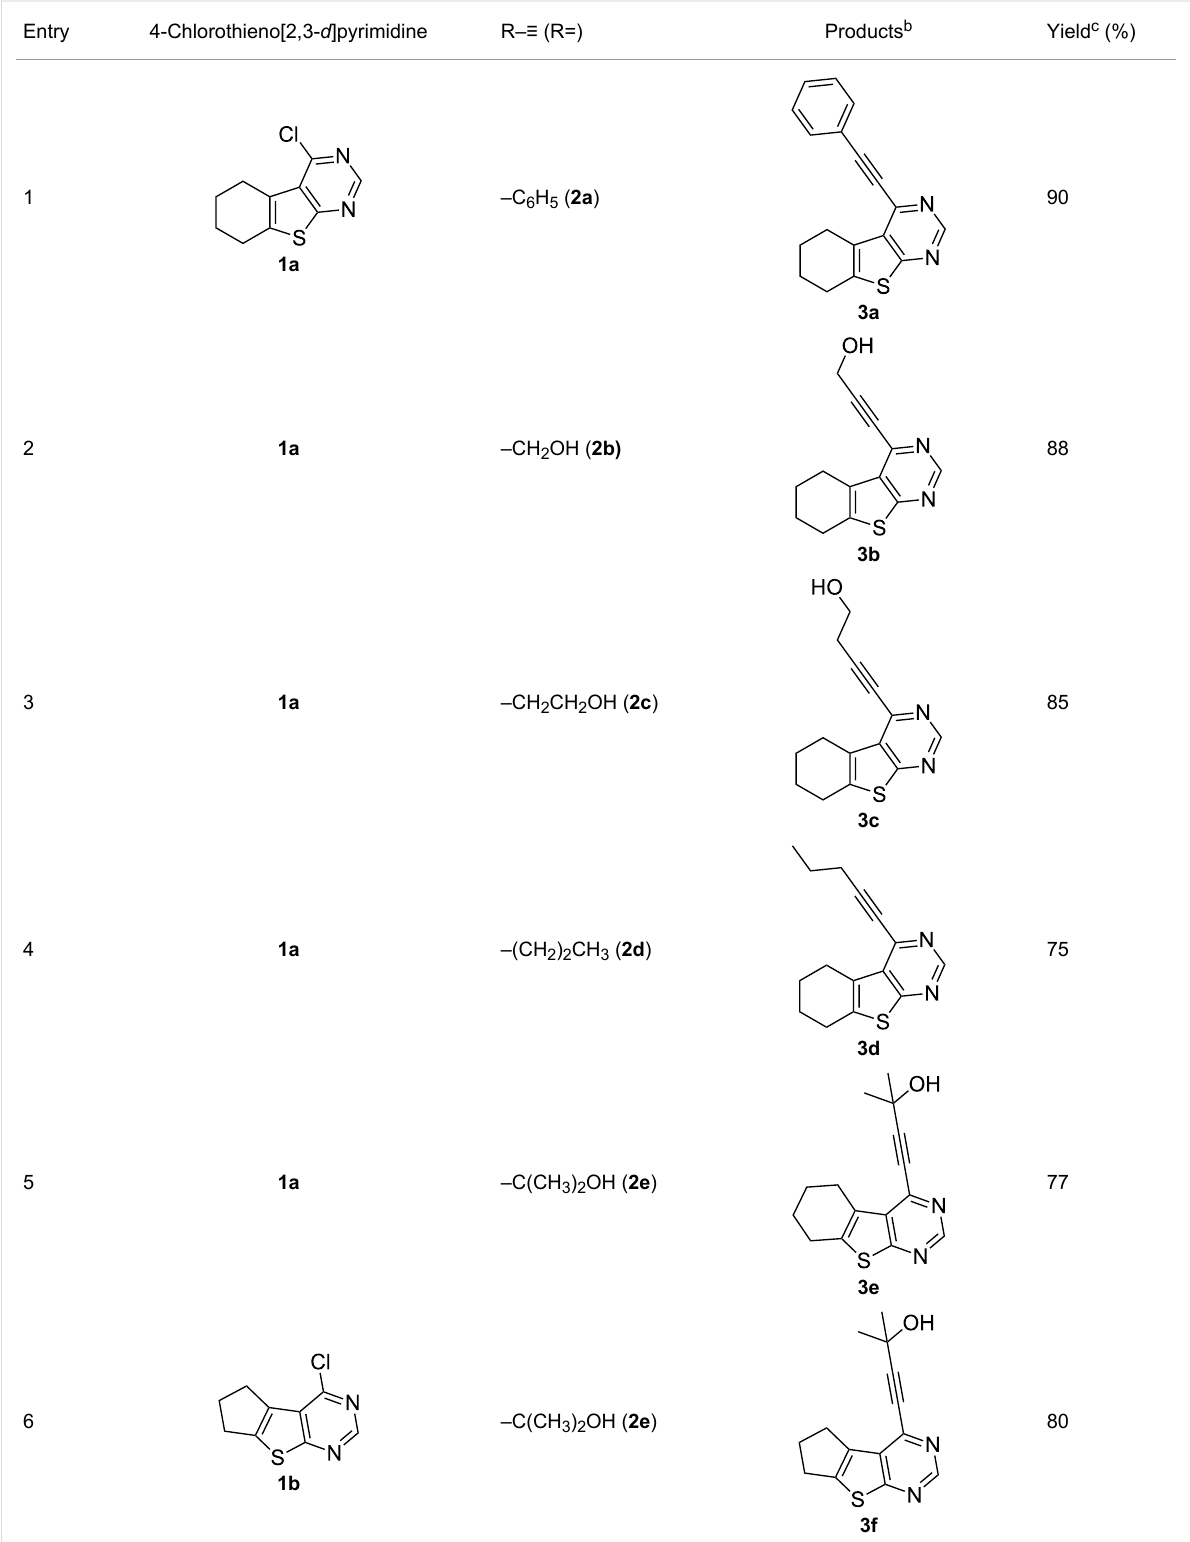
Table 2: Pd/C-mediated synthesis of 4-alkynylthieno[2,3- d ]pyrimidine in methanol. a